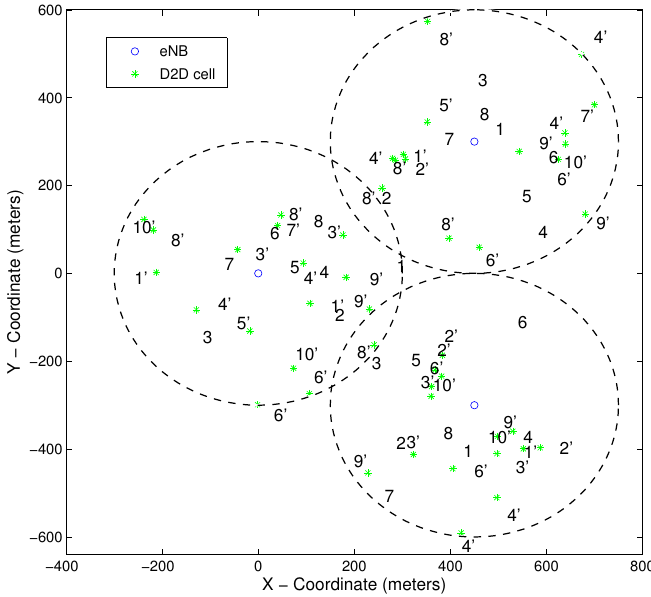
Figure 2. Topology of the initial Resource Block (RB) allocation.